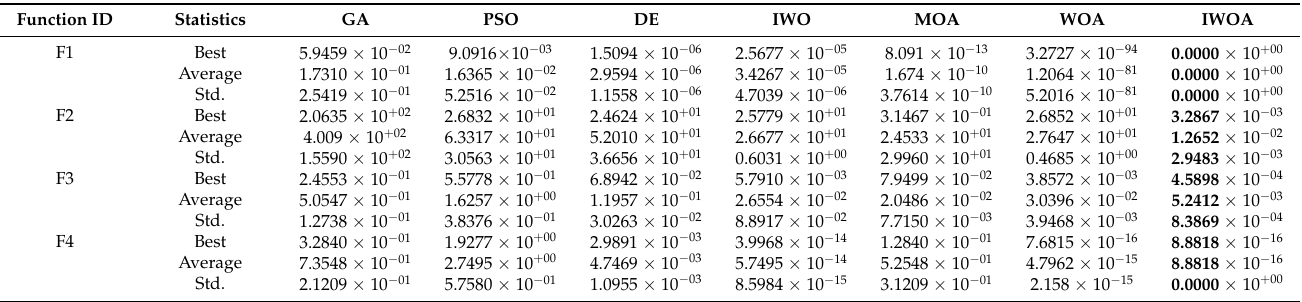
Figure 2. Simulation experiment results. ( a ) convergence curves of F1; ( b ) convergence curves of F2; ( c ) convergence curves of F3; ( d ) convergence curves of F4. Table 3. Results of algorithms on basic benchmark